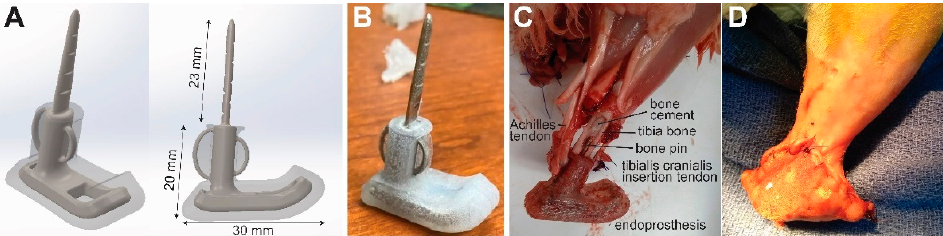
Figure 1. ( A ) Computer-aided design (CAD) model of the endoprosthesis. ( B ) Rigid foot–ankle en- doprosthesis prototype fabricated with a 316L stainless steel core and a silicone cover. ( C ) Endo- prosthesis in situ in rabbit E0, postmortem. ( D ) Skin flap closed over endoprosthesis in vivo in rabbit E1 immediately after surgery.